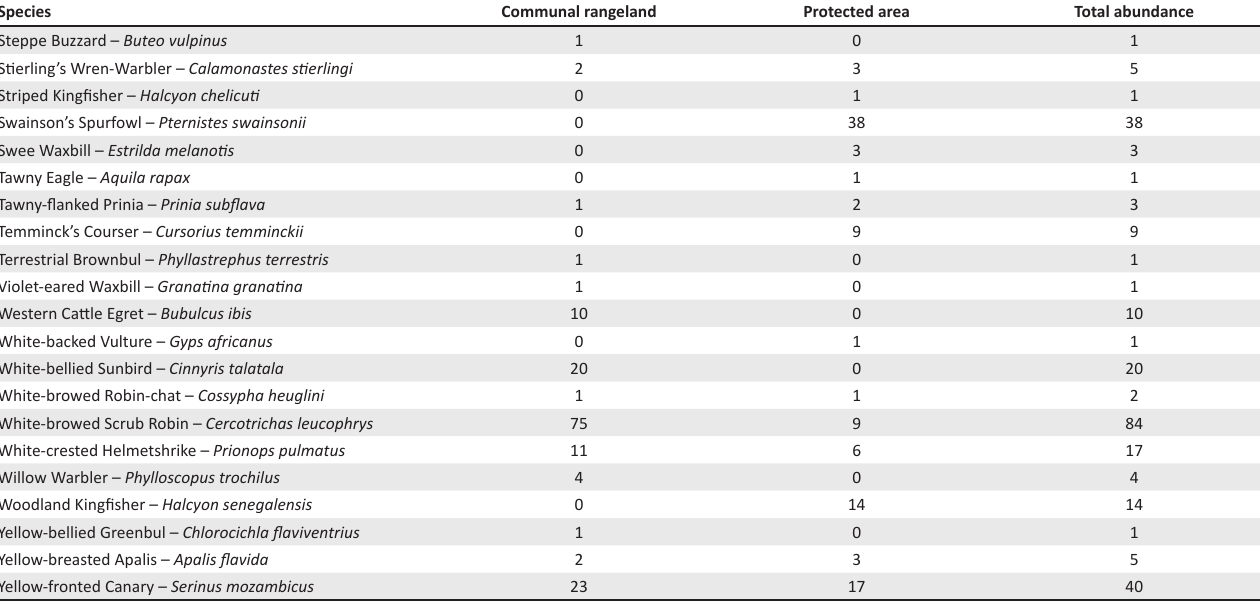
TABLE 3-A1 (Continues...): Counts of birds surveyed per land-use type in alphabetical order.